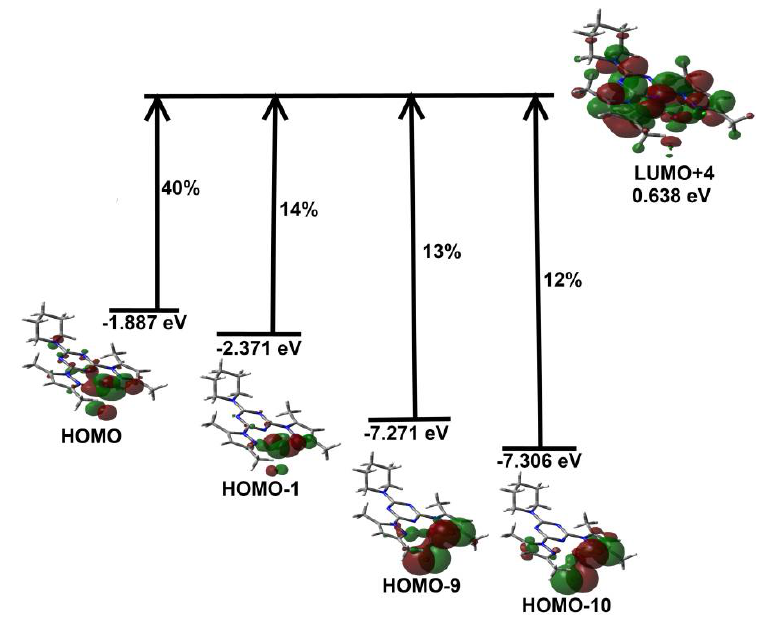
Figure 11. Origin of the electronic spectral band observed in ethanol for complex 2 .